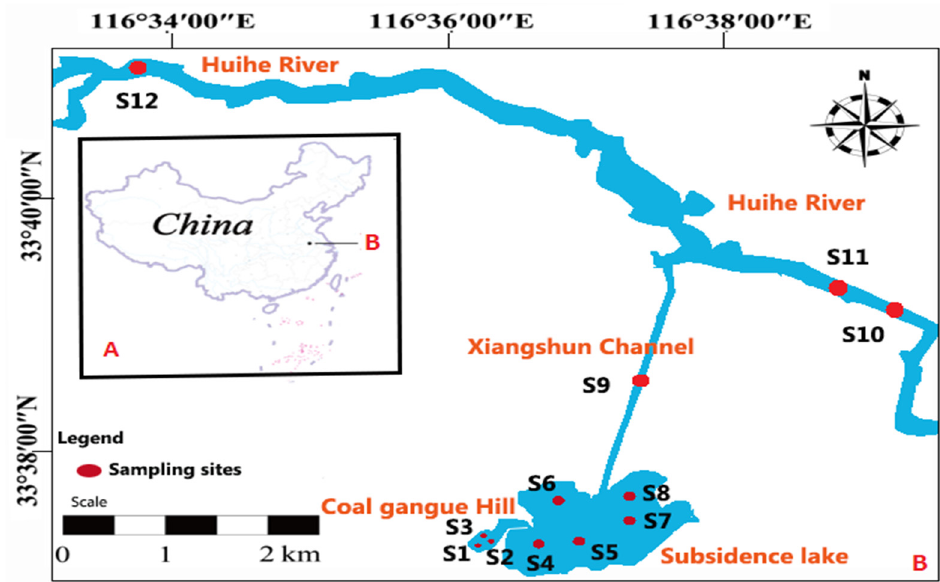
Figure 1. Study area and sampling points. ( A ) map of China, and ( B ) sampling sites in the coal mining subsidence lake and in the Huihe